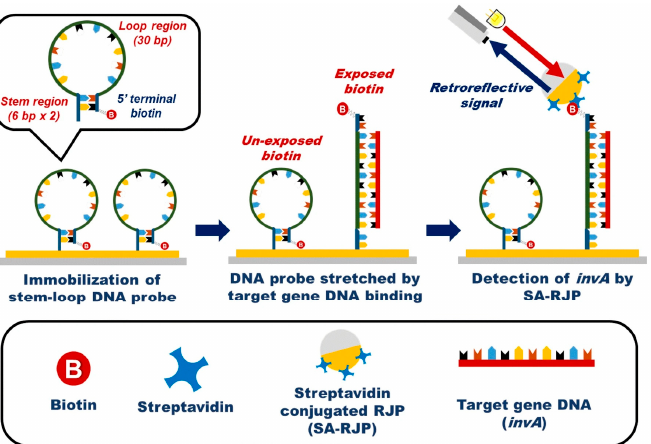
Figure 7. Schematic illustration of the Salmonella target gene DNA system detection using retroreflective Janus microparticles. Reproduced from [118].